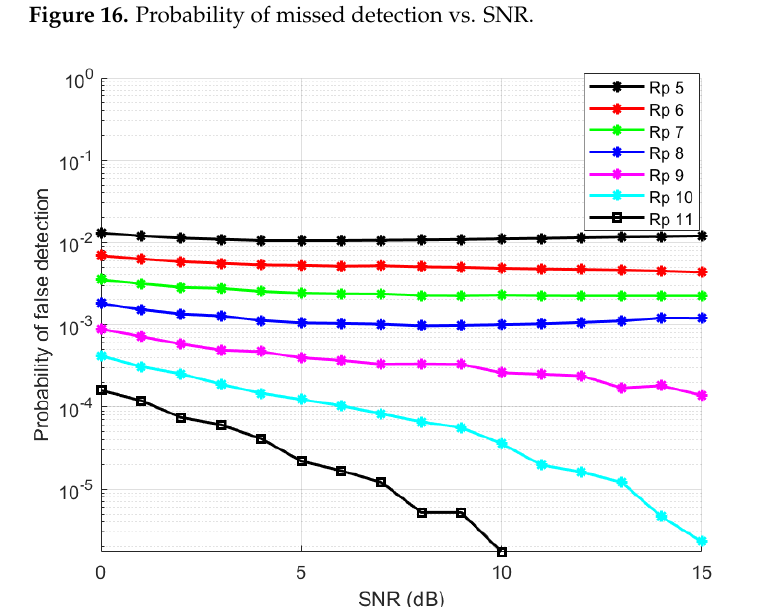
Figure 17. Probability of false detection in ROAD statistics-based detection for different threshold value vs.